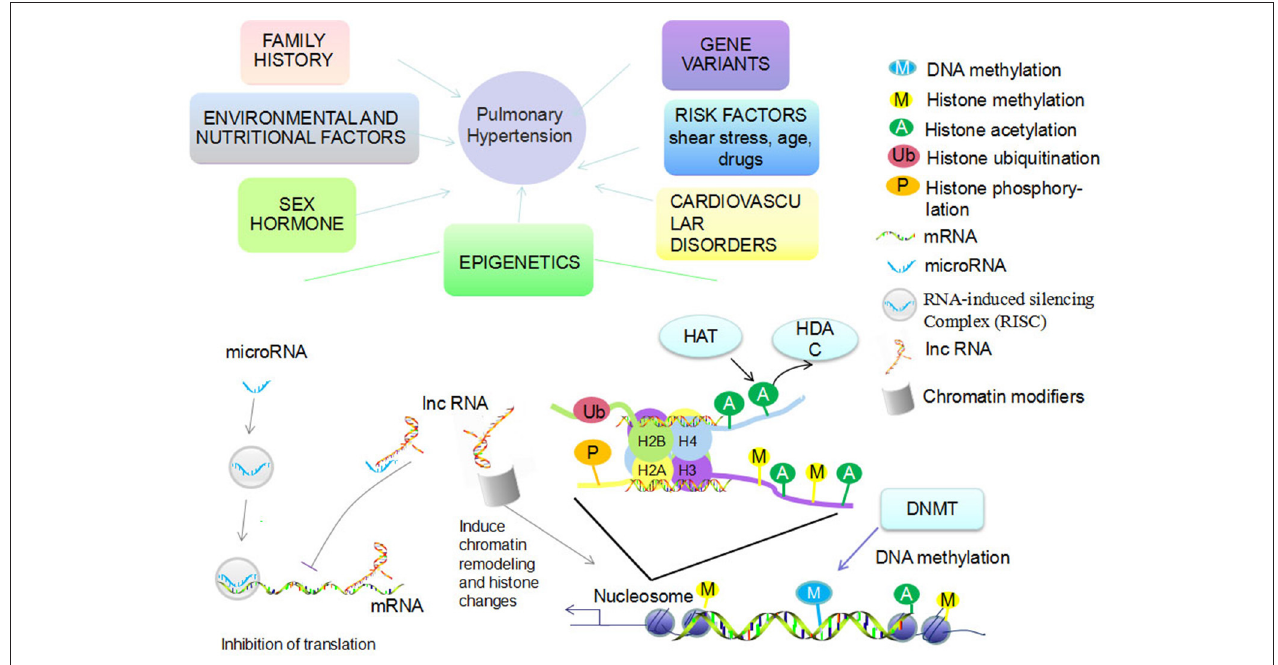
FIGURE 1 | Etiologies account for PAH and epigenetic mechanisms. Multiple etiologies account for PAH, including gene variants, family history, levels of sex hormones, risk factors (shear stress, age, drugs), cardiovascular disorders, environmental (hypoxia, virus infection), and nutritional factors. Epigenetic mechanisms mainly include DNA methylation via DNA methyltransferase (DNMT) and histone modification (methylation, acetylation, ubiquitination, phosphorylation, etc.). Histone acetylation and deacetylation are regulated by histone acetyltransferase (HAT) and histone deacetylases (HDAC). The functional miRNA is incorporated into RNA-induced silencing complex (RISC) to silence gene expression, inhibit translation, or directly promote degradation of target mRNAs. LncRNA recruit chromatin modifiers while inducing chromatin remodeling and histone modifications. LncRNA can then either bind to mRNA to inhibit translation or bind to miRNA to inhibit RISC